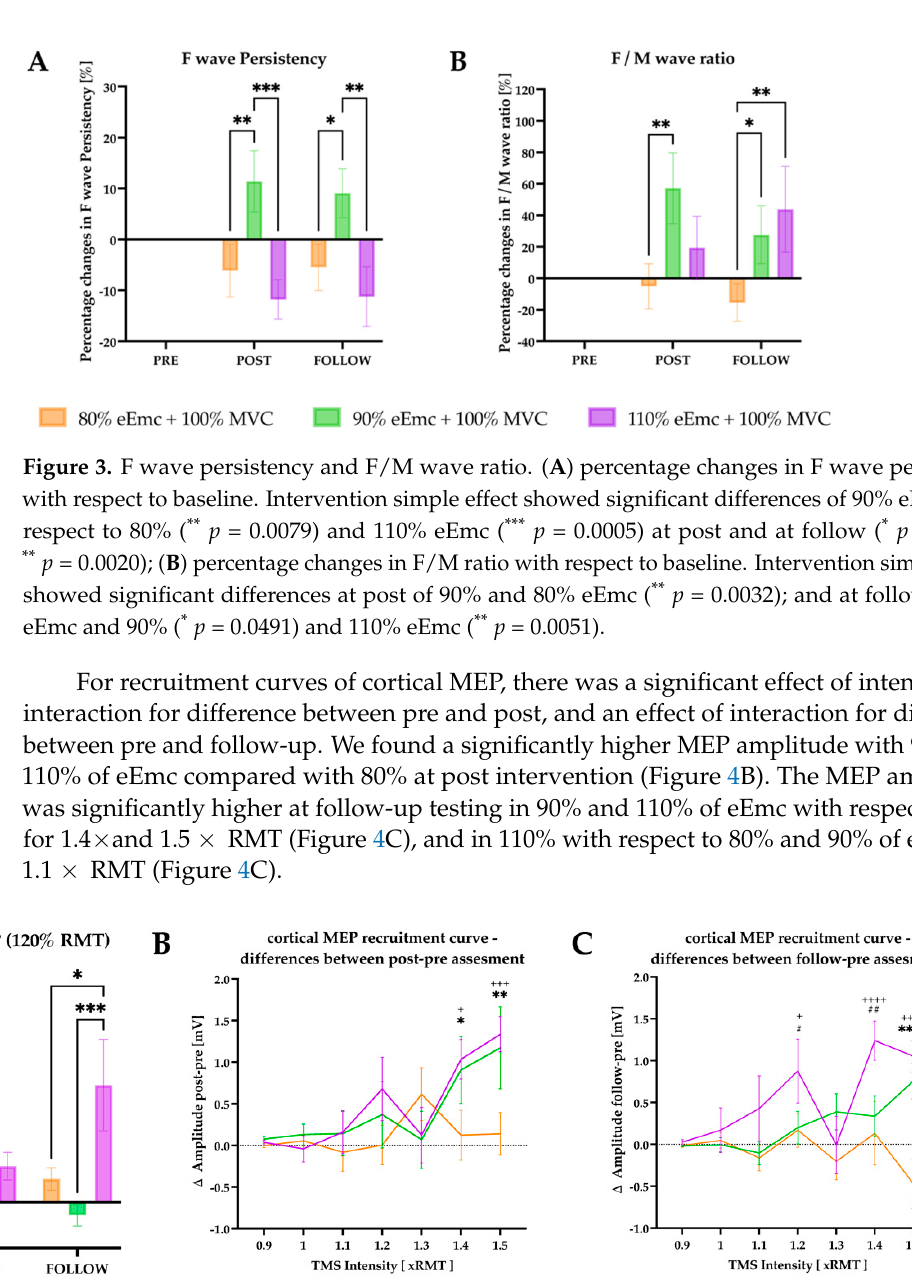
Table 3. Raw data and statistics of functional and motor strength and neurophysiological assessment during 100% or 50% of hand grip strength during hand training combined with the 90% of electrical stimulus intensity for eEmc.